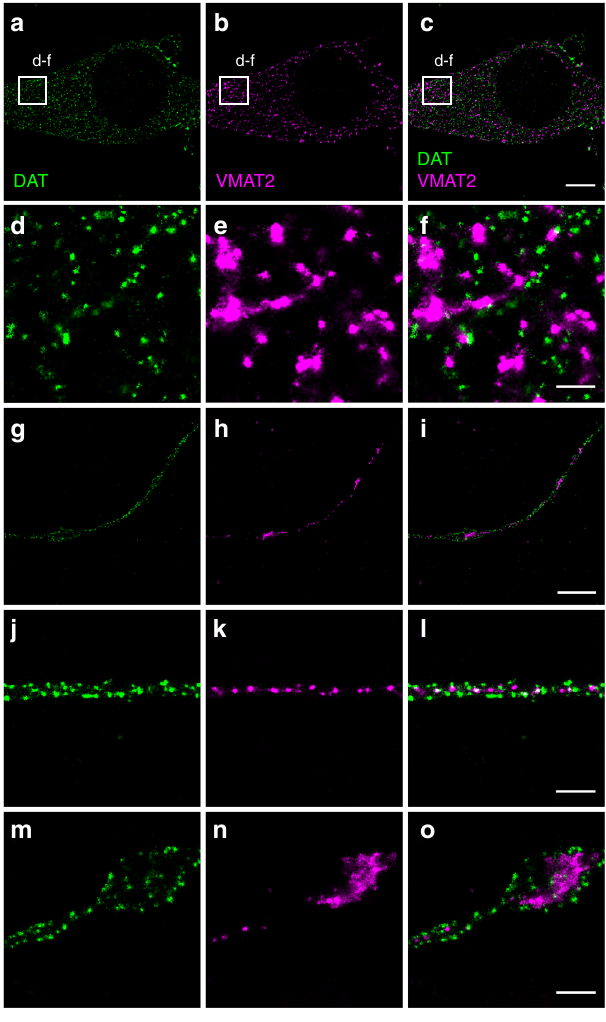
Fig. 7 Cross-section through the cell body, extensions and varicosities of dopaminergic neurons showing by dual-color dSTORM imaging the distinct distribution of the vesicular monoamine transporter-2 (VMAT2) compared to DAT. DAT was visualized by immunolabeling and Alexa647-conjugated secondary antibody. VMAT2 was visualized by immunolabeling and CF568-conjugated secondary antibody. a Somatic distribution of DAT. b Somatic distribution of VMAT2. c Merged image of a and b . d – f Enlarged STORM images corresponding to the boxes shown in a – c . g Distribution of DAT in extension with varicosities. h Distribution of VMAT2 in extension with varicosities. i Merged image of g and h . j Distribution of DAT in extension. k Distribution of VMAT2 in extension. l Merged image of j and k . m Distribution of DAT in varicosity. n Distribution of VMAT2 in